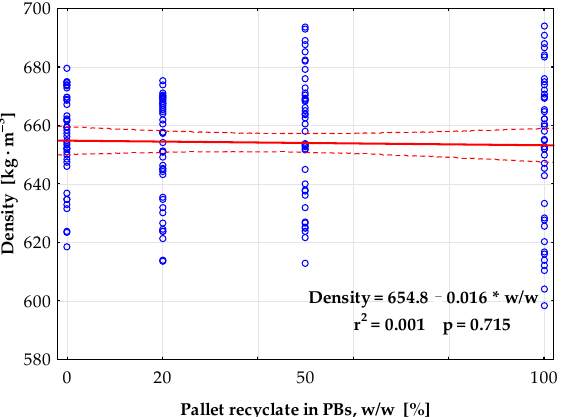
Figure 4. Density of PBs containing different amount of particles from recycled pallets.